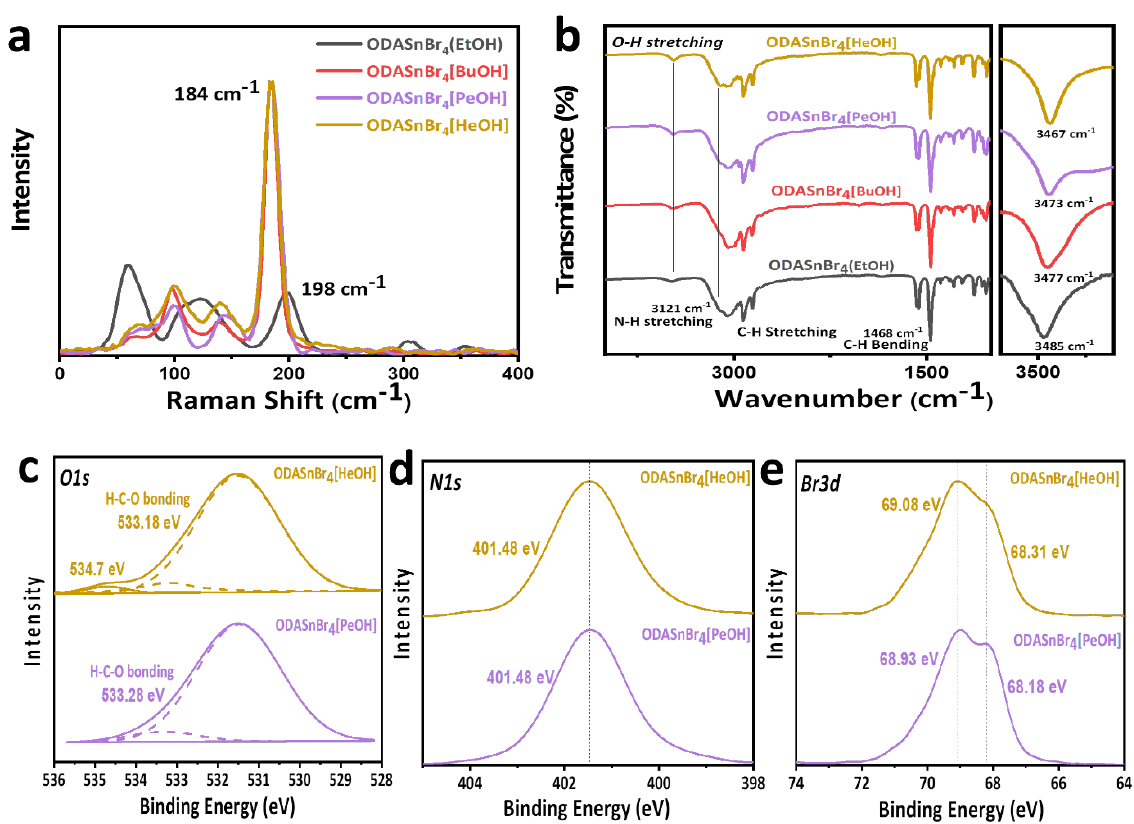
Figure 3. ( a ) Raman spectra and ( b ) FTIR spectra of ODASnBr 4 [EtOH], ODASnBr 4 [BuOH], ODASnBr 4 [PeOH], ODASnBr 4 [HeOH]. ( c – e ) XPS spectra of ( c ) O1s, ( d ) N1s, ( e ) Br3d core-levels of ODASnBr 4 [PeOH], and ODASnBr 4 [HeOH] perovskite microcrystals.